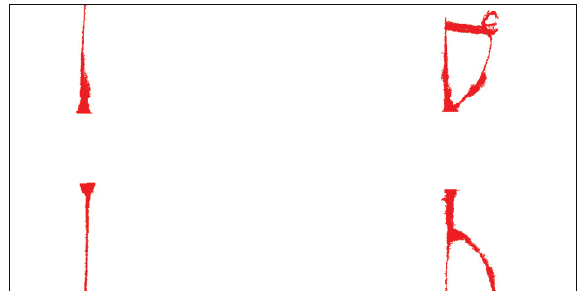
Figure 14: Principal binary image ∼ core flow line region.